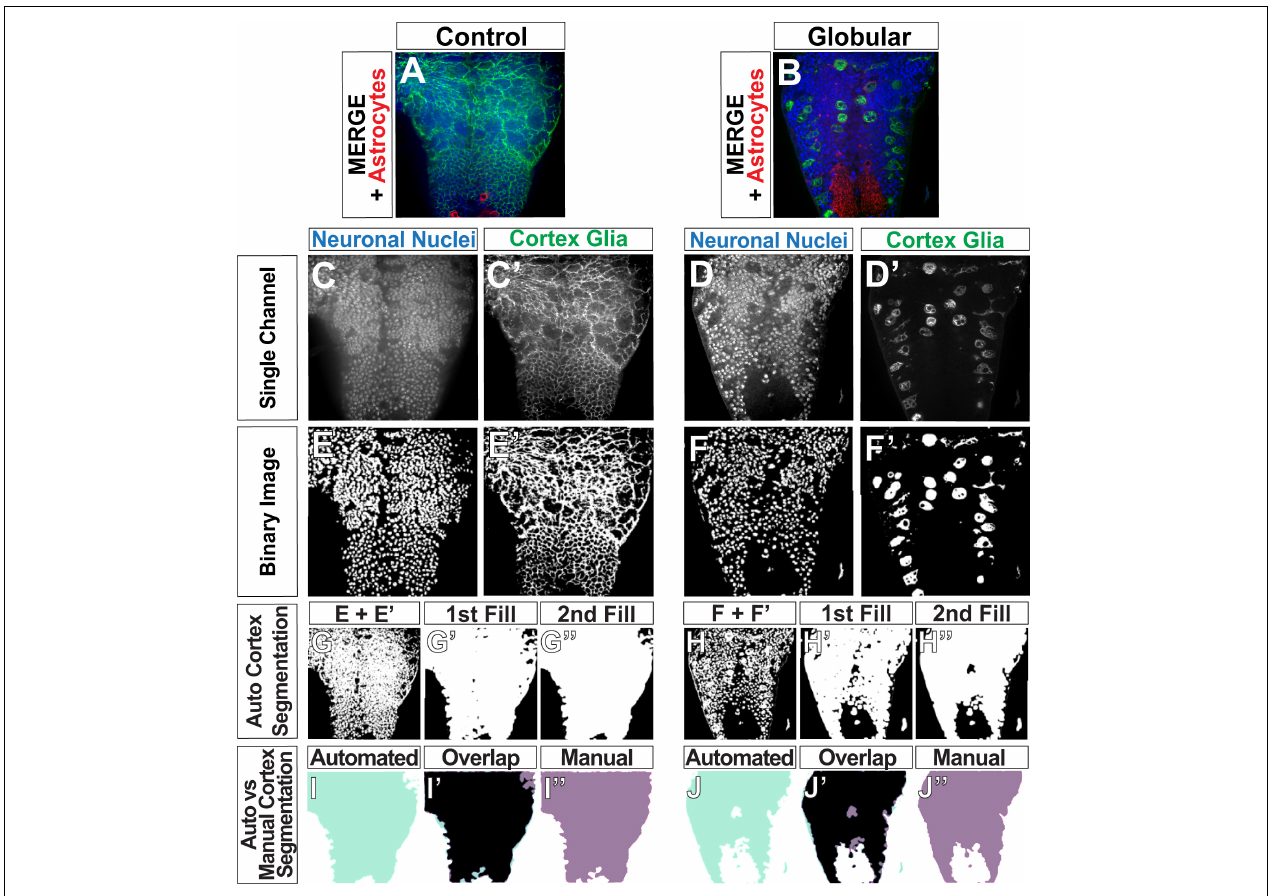
FIGURE 3 | Automated determination of the cortex region. (A,B) Original images of control (A) and globular CG (B) consisting of three channels: CG (green), neuronal nuclei (blue), and astrocytes (red). (C–F) Gray scale images of single channels (C–D’) were converted binary images (E–F’) . (G–H”) Binary images of neuronal nuclei and CG were then combined to define the cortex (G,H) . Gaps between the nuclei and CG membranes were filled to produce solid white area covering the entire cortex (G’,G”,H’,H”) . (I–J”) Comparison of the cortex segmentations obtained by the automated pipeline (aqua, I,J ) and by manual tracing of the same image (purple, I”,J” ), with the overlap depicted between the two in black ( I’,J’ ,